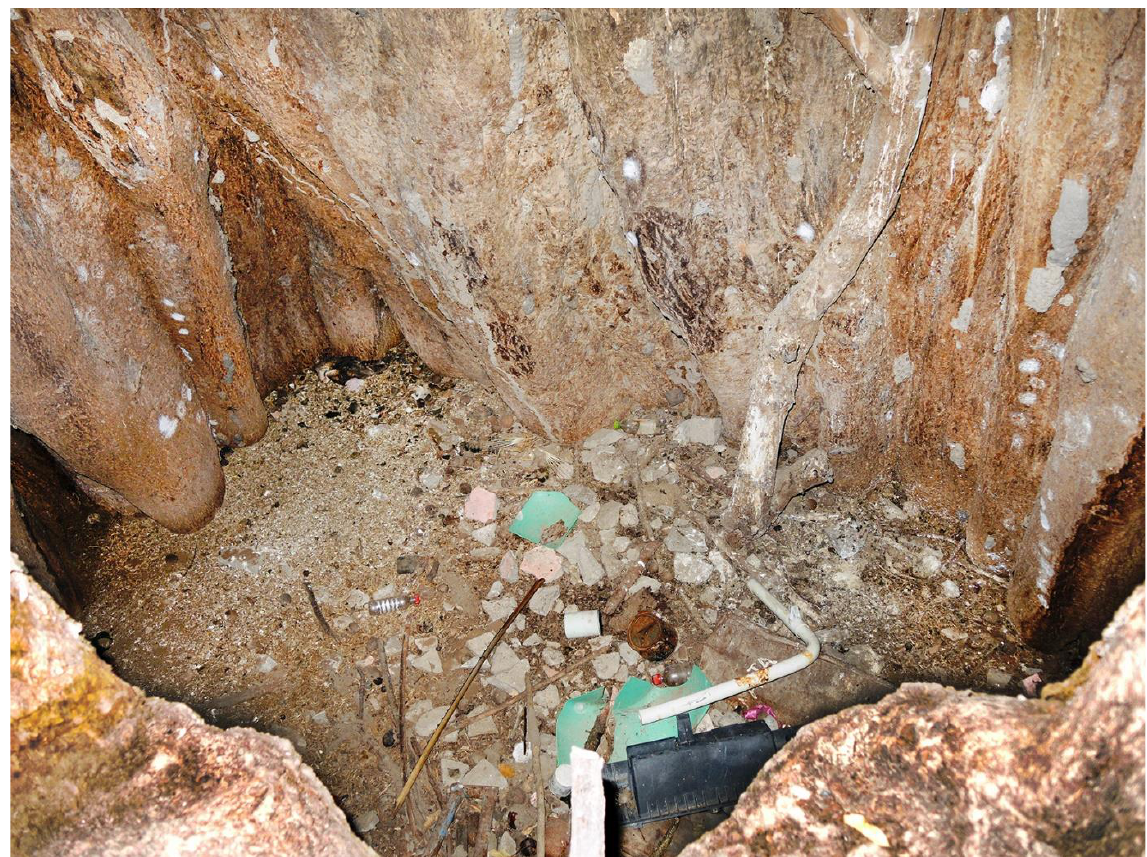
Figure 12. The base of the false cavity of the Amadhila baobab was covered by scraps, trash and waste, thrown through the high opening at the height of 3.50 m.